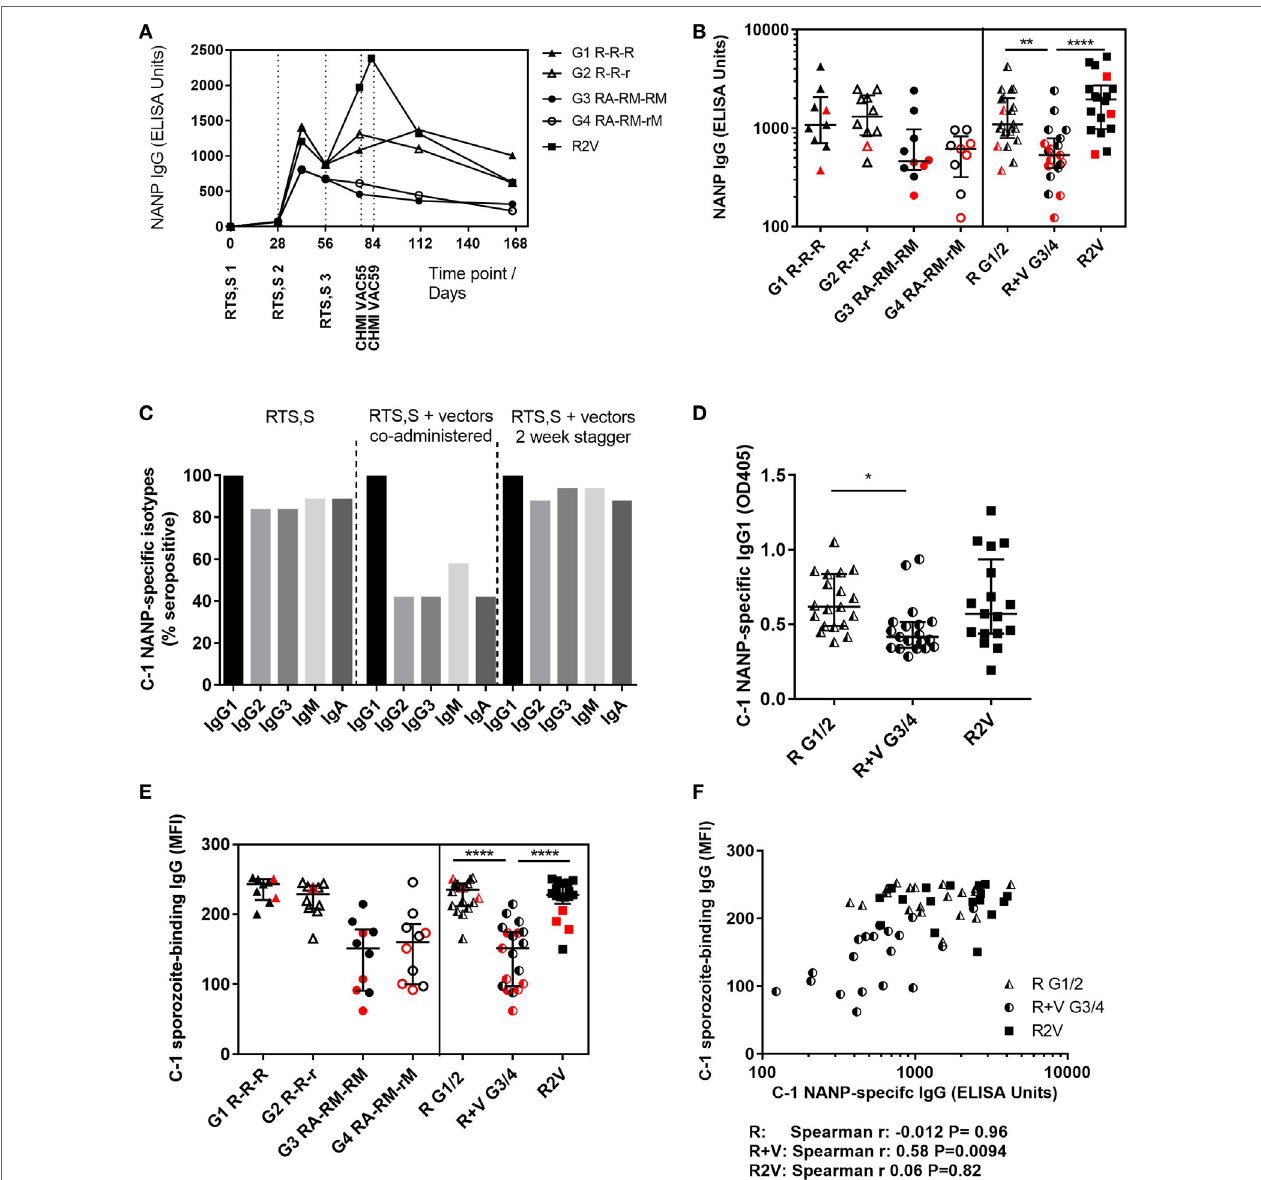
FigUre 1 | Antibody quantity and quality. (a) Median NANP-specific IgG time courses. (B) Total IgG titers against the CSP repeat region NANP in each group at D76 (2 weeks after third dose of RTS,S/AS01B), in G1/2 combined (R) and G3/4 combined (R + V) or in the staggered regimen (R2V), Kruskal–Wallis with Dunn’s post-test P < 0.0001. (c) NANP-specific isotype and IgG subclass responses at C-1. (D) NANP-specific IgG1 at C-1, Kruskal–Wallis P = 0.0062. (e) MFI of sporozoite-binding IgG at C-1 measured by IFA, Kruskal–Wallis P < 0.0001. (F) Relationship between NANP IgG titer and level of sporozoite-binding at C-1. Volunteers receiving RTS,S/AS01B alone (G1/2, R) Spearman r : − 0.012, P = 0.96, RTS,S/AS01B co-administered with vectors (G3/4, R + V) Spearman r : 0.58, P = 0.0094 or RTS,S/AS01B and viral vectors given in a staggered regimen Spearman r : 0.06, P = 0.82. Medians + IQRs shown and non-protected volunteers highlighted in red for all column graphs. Abbreviations: R G1/2, RTS,S/AS01B vaccinated; R + V G3/4, RTS,S/AS01B and viral-vectored vaccines co-administered; R2V, RTS,S/AS01B and viral-vectored vaccines at a 2-week stagger; A, ChAd63 ME-TRAP; M, MVA ME-TRAP; R, 50 µg third dose of RTS,S/AS01B; r, 10 µg third dose of RTS,S/AS01B; CHMI, controlled human malaria infection; C-1, day before CHMI; CSP, circumsporozoite protein; TRAP, thrombospondin-related adhesive protein; IQRs, inter-quartile ranges; IFA, immunofluorescence assay; MFI, median fluorescence